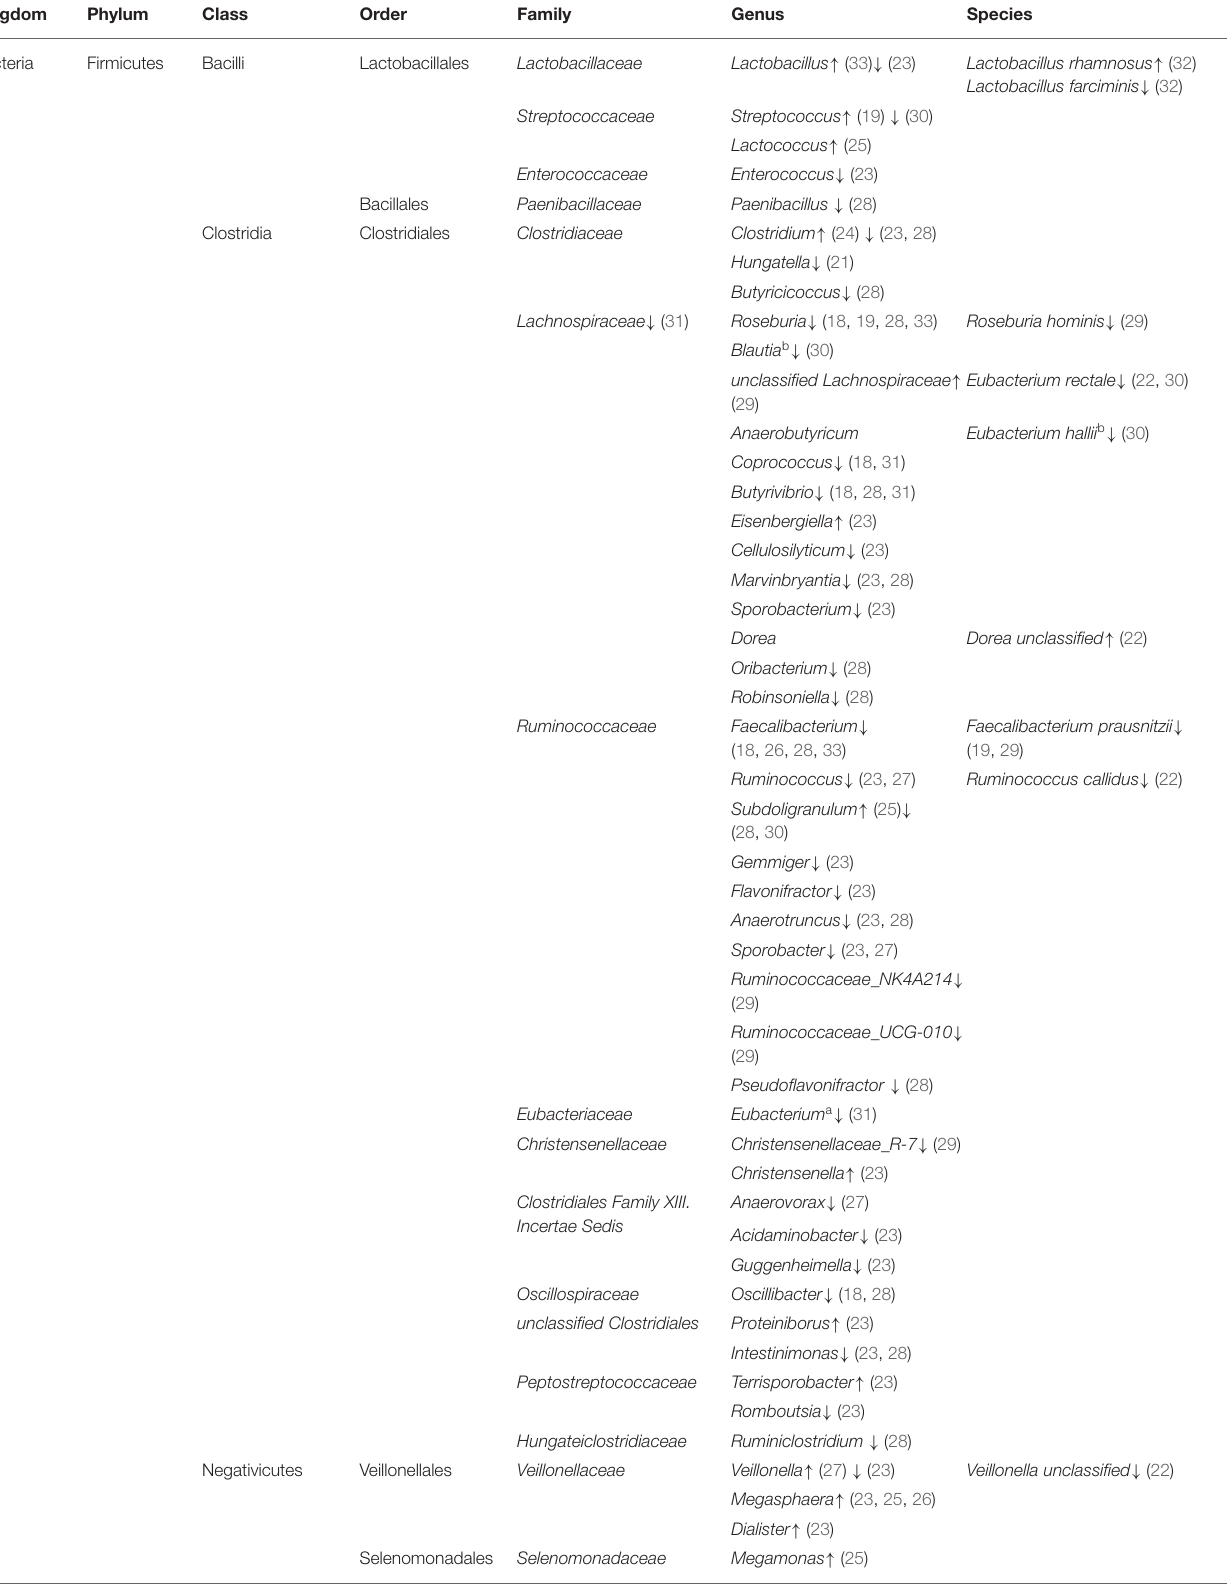
TABLE 3 | Major taxa with disparate representation in